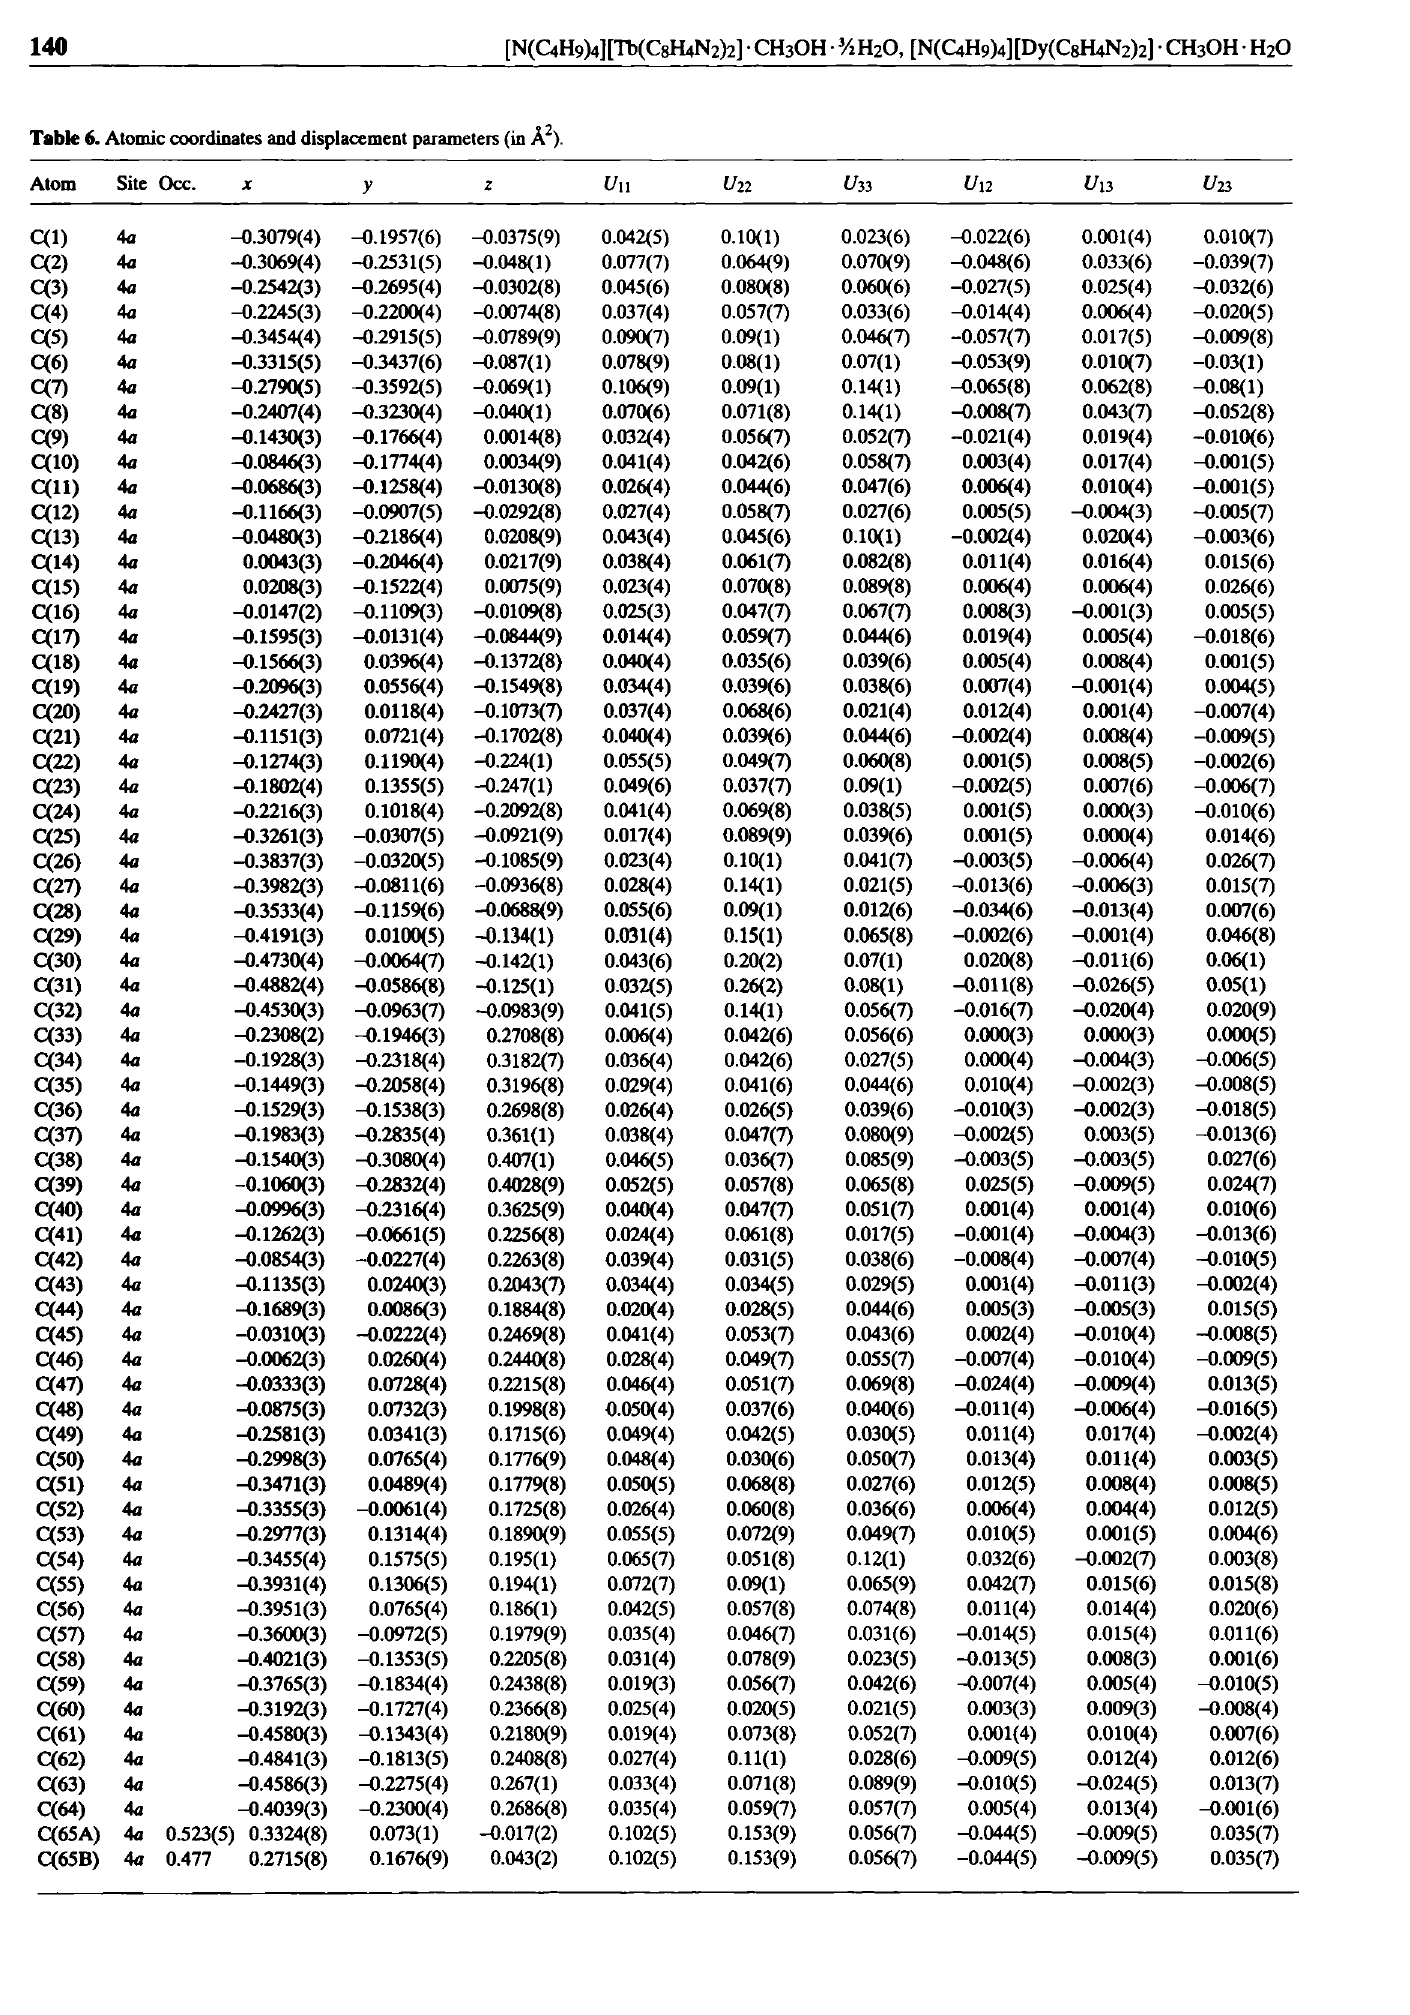
Table 6. Atomic coordinates and displacement parameters (in A 2 ). Atom Site